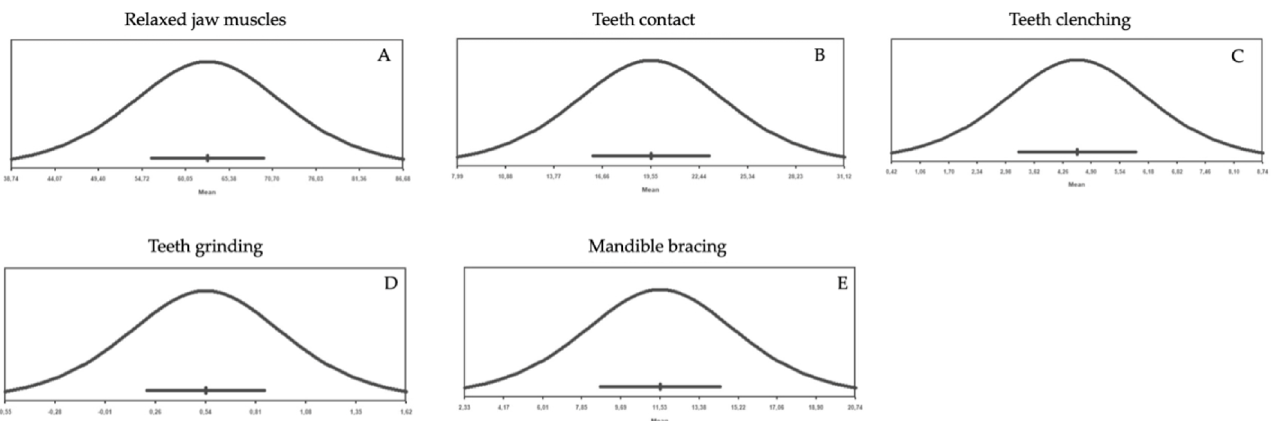
Figure 2. ( A – E ) Mean values distribution of the frequency data and confidence interval for AB behaviors (e.g., relaxed jaw muscles, teeth contact, teeth clenching, teeth grinding, mandible bracing)—comparison among studies [8,10,12–14,16,18,19].